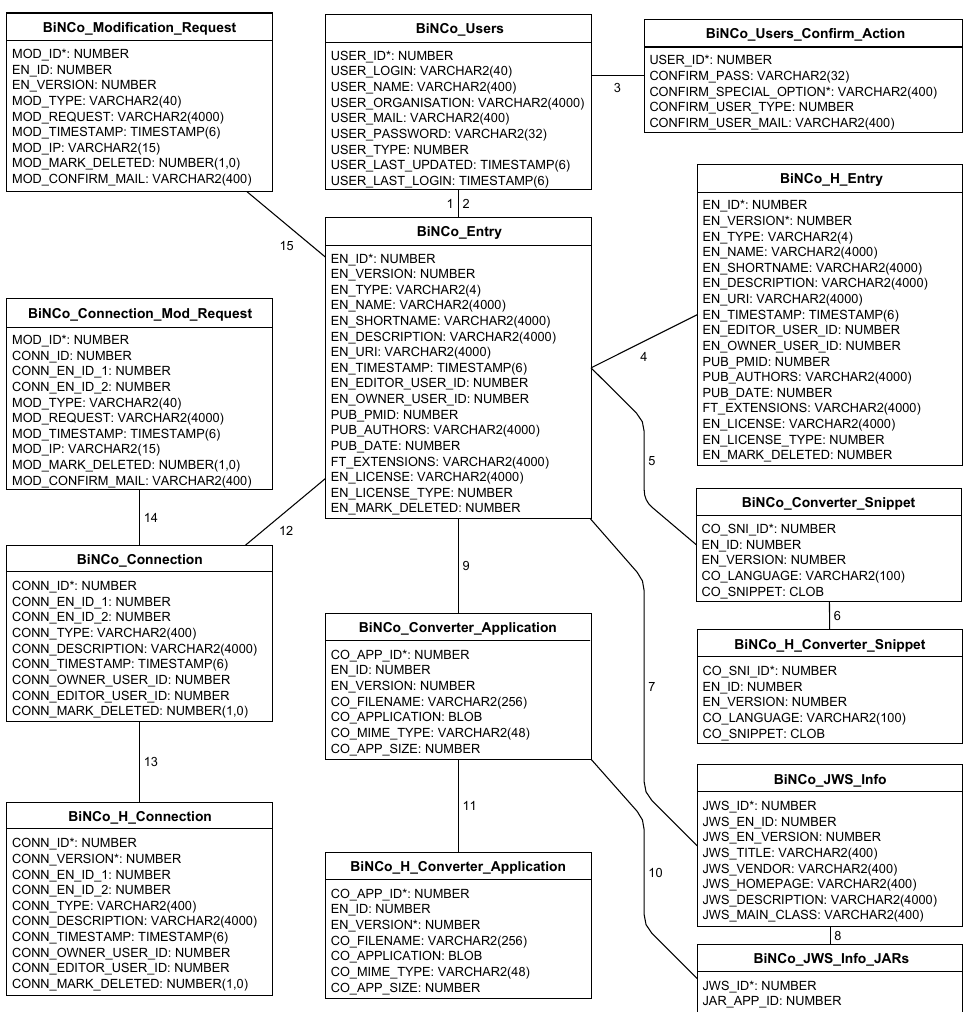
Figure 2: Database schema of BiNCo-wiki. Each box represents one table in the database. The ta- ble name is displayed in the head. Columns of each table are given below the table name. Primary keys are marked with an asterisk